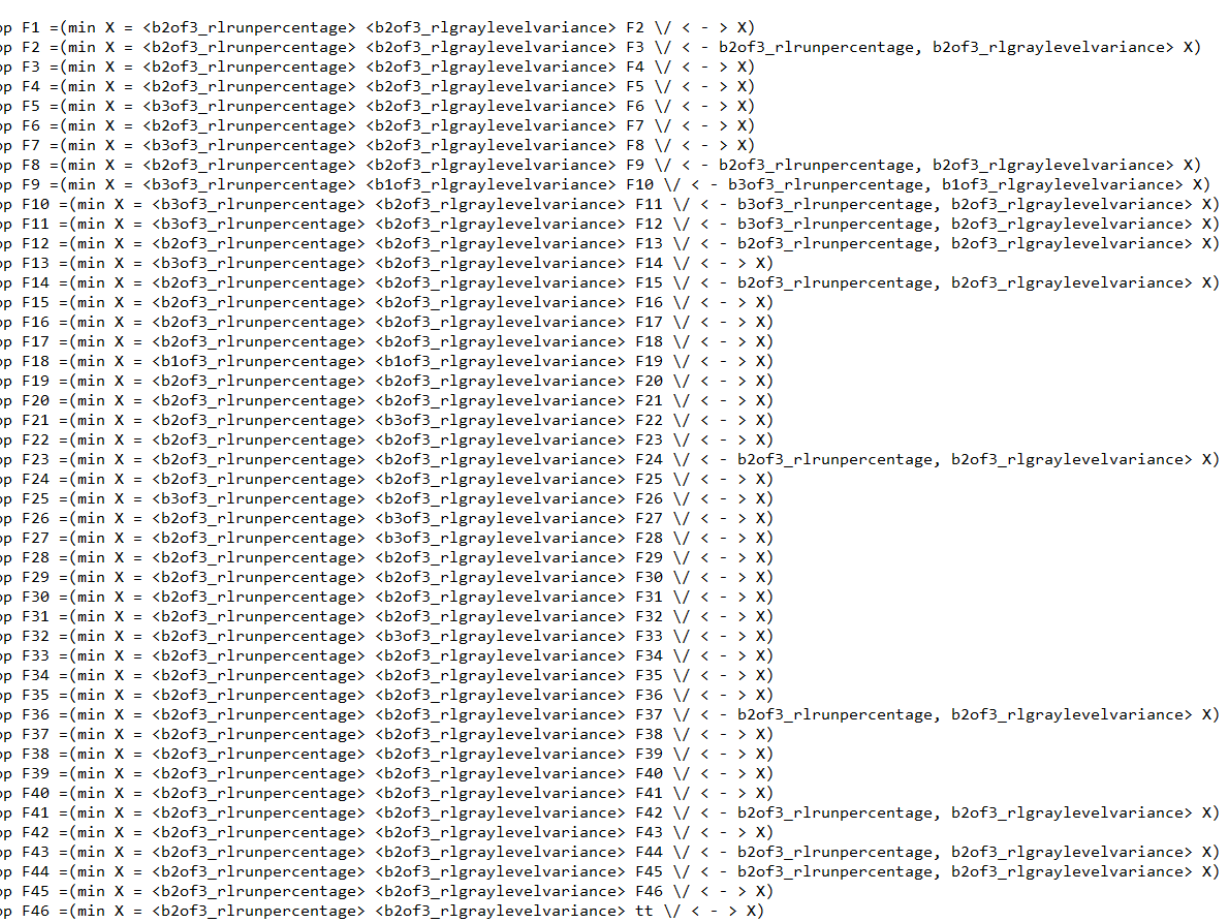
Figure A2. For reasons of coherence and clarity, the Figure above shows the property in the Mu-calculus algebra for GLRLM Feature class. For further information, please refer to Milner’s book